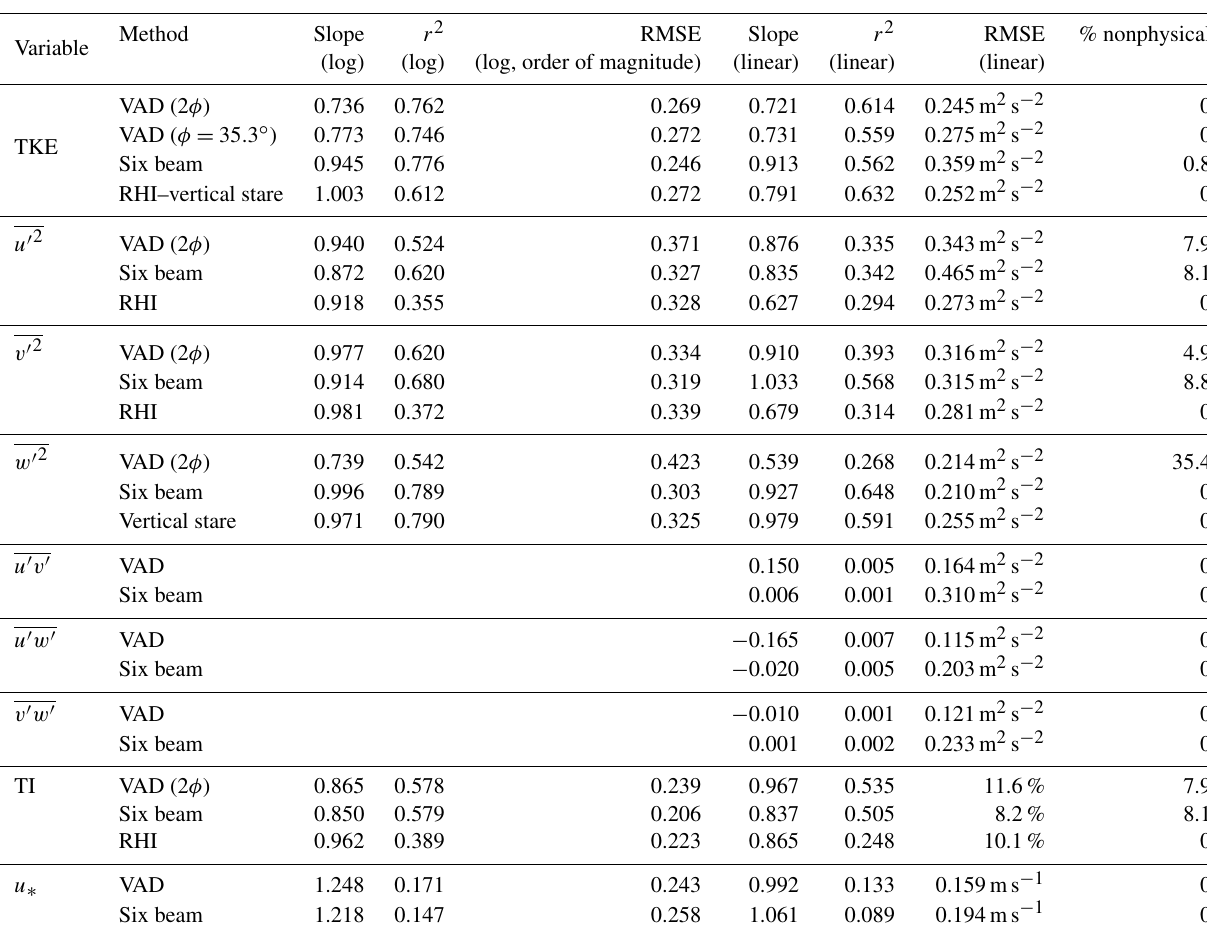
Table A1. Statistical comparison between sonic anemometer and lidar observations of all measured turbulence variables. Slope, r 2 , and RMSE values are computed separately for regression analysis on a logarithmic and linear scale. The column “% nonphysical” in- dicates the percent of measurements that are negative or